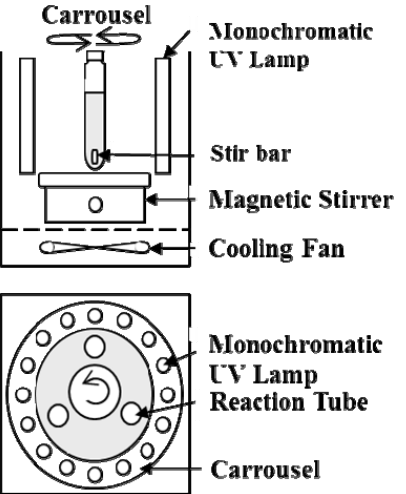
Figure 1. Experimental